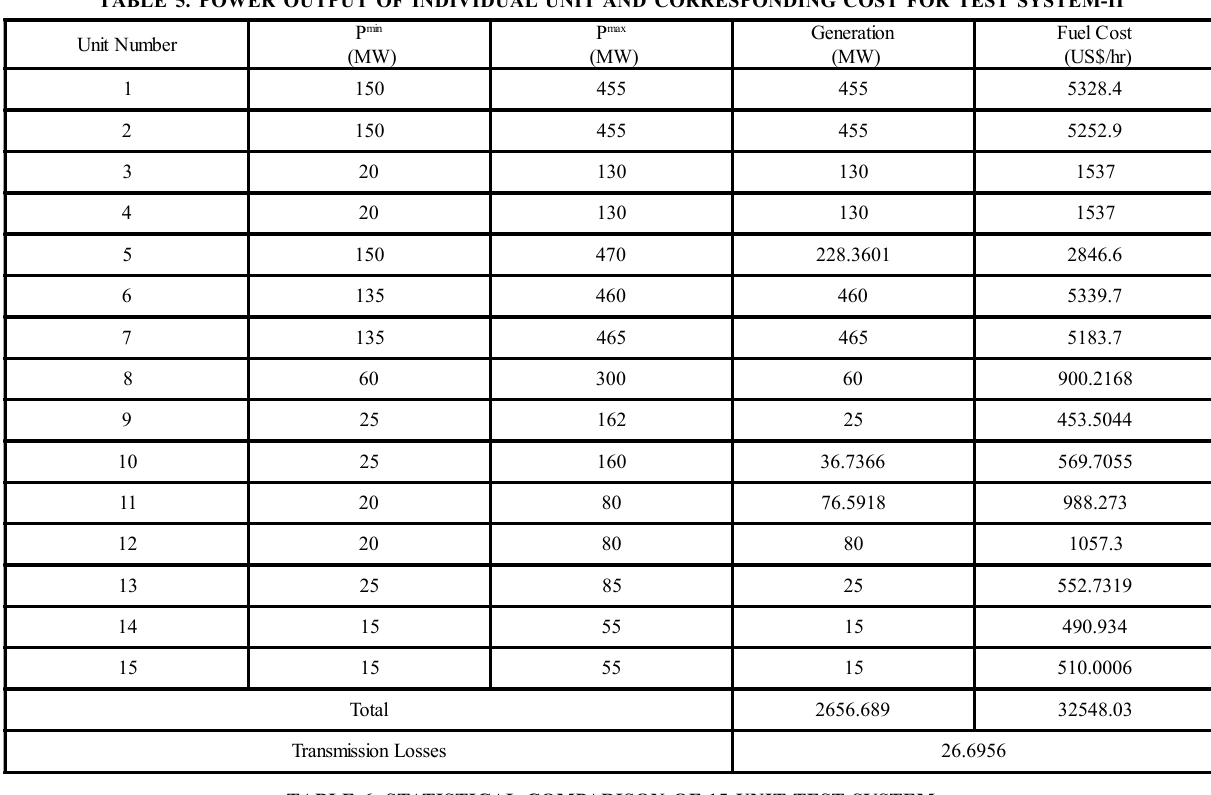
TABLE 5. POWER OUTPUT OF INDIVIDUAL UNIT AND CORRESPONDING COST FOR TEST SYSTEM-II